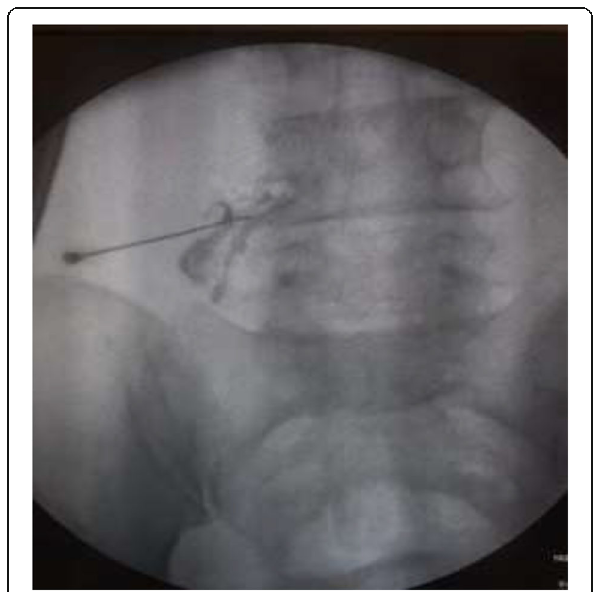
Fig. 10 A – P Fluoroscope verification of dye spread around nerve